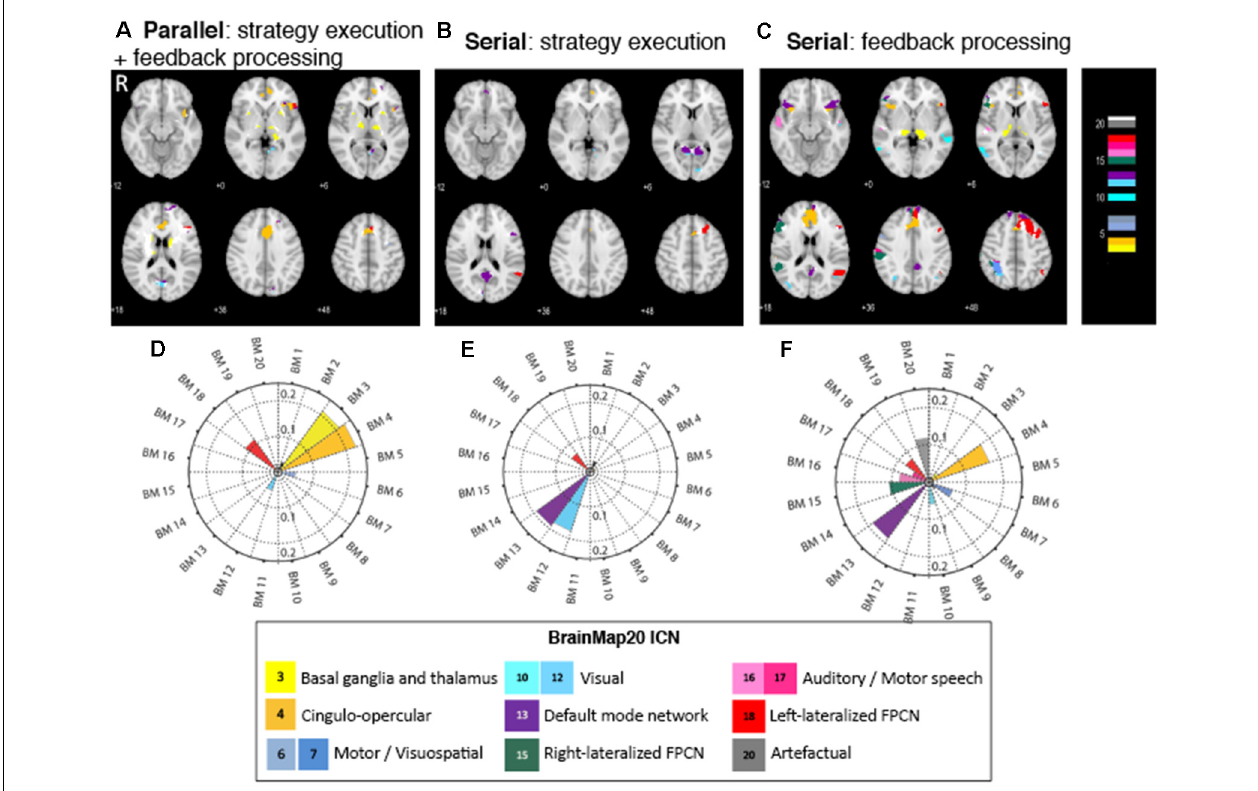
FIGURE 3 | (A–C) Brain regions activated in the NF subcomponents across the three different conditions. Color code corresponds to the BrainMap20 (Laird et al., 2011) atlas base map. (D–F) Spatial correlation of brain activity in NF with the BrainMap20 intrinsic connectivity networks (ICNs). FPCN, frontoparietal control network. Thresholded and unthresholded activation maps are available at